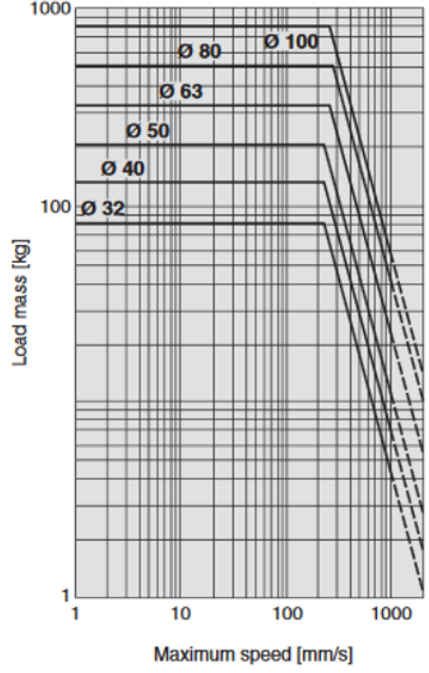
Fig. 7. Check of internal pneumatic cushioning